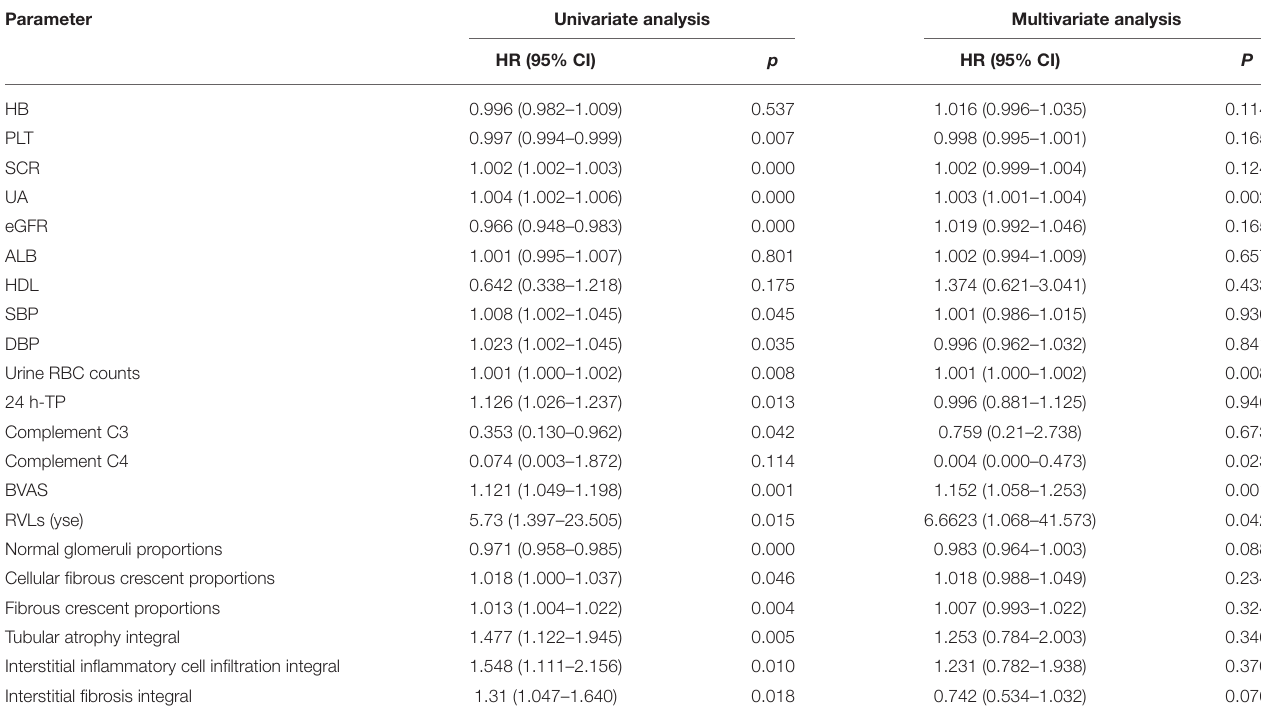
TABLE 7 | Cox proportional hazard regression model describing the long-term risk of end-stage renal disease (ESRD) or death in patients with ANCA-related renal vasculitis.